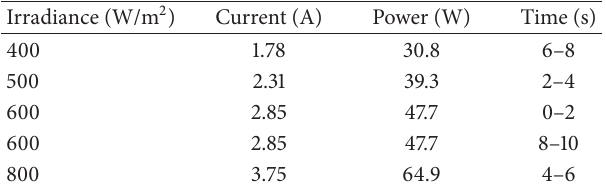
Table 1: Variation in power for the data set collected for the